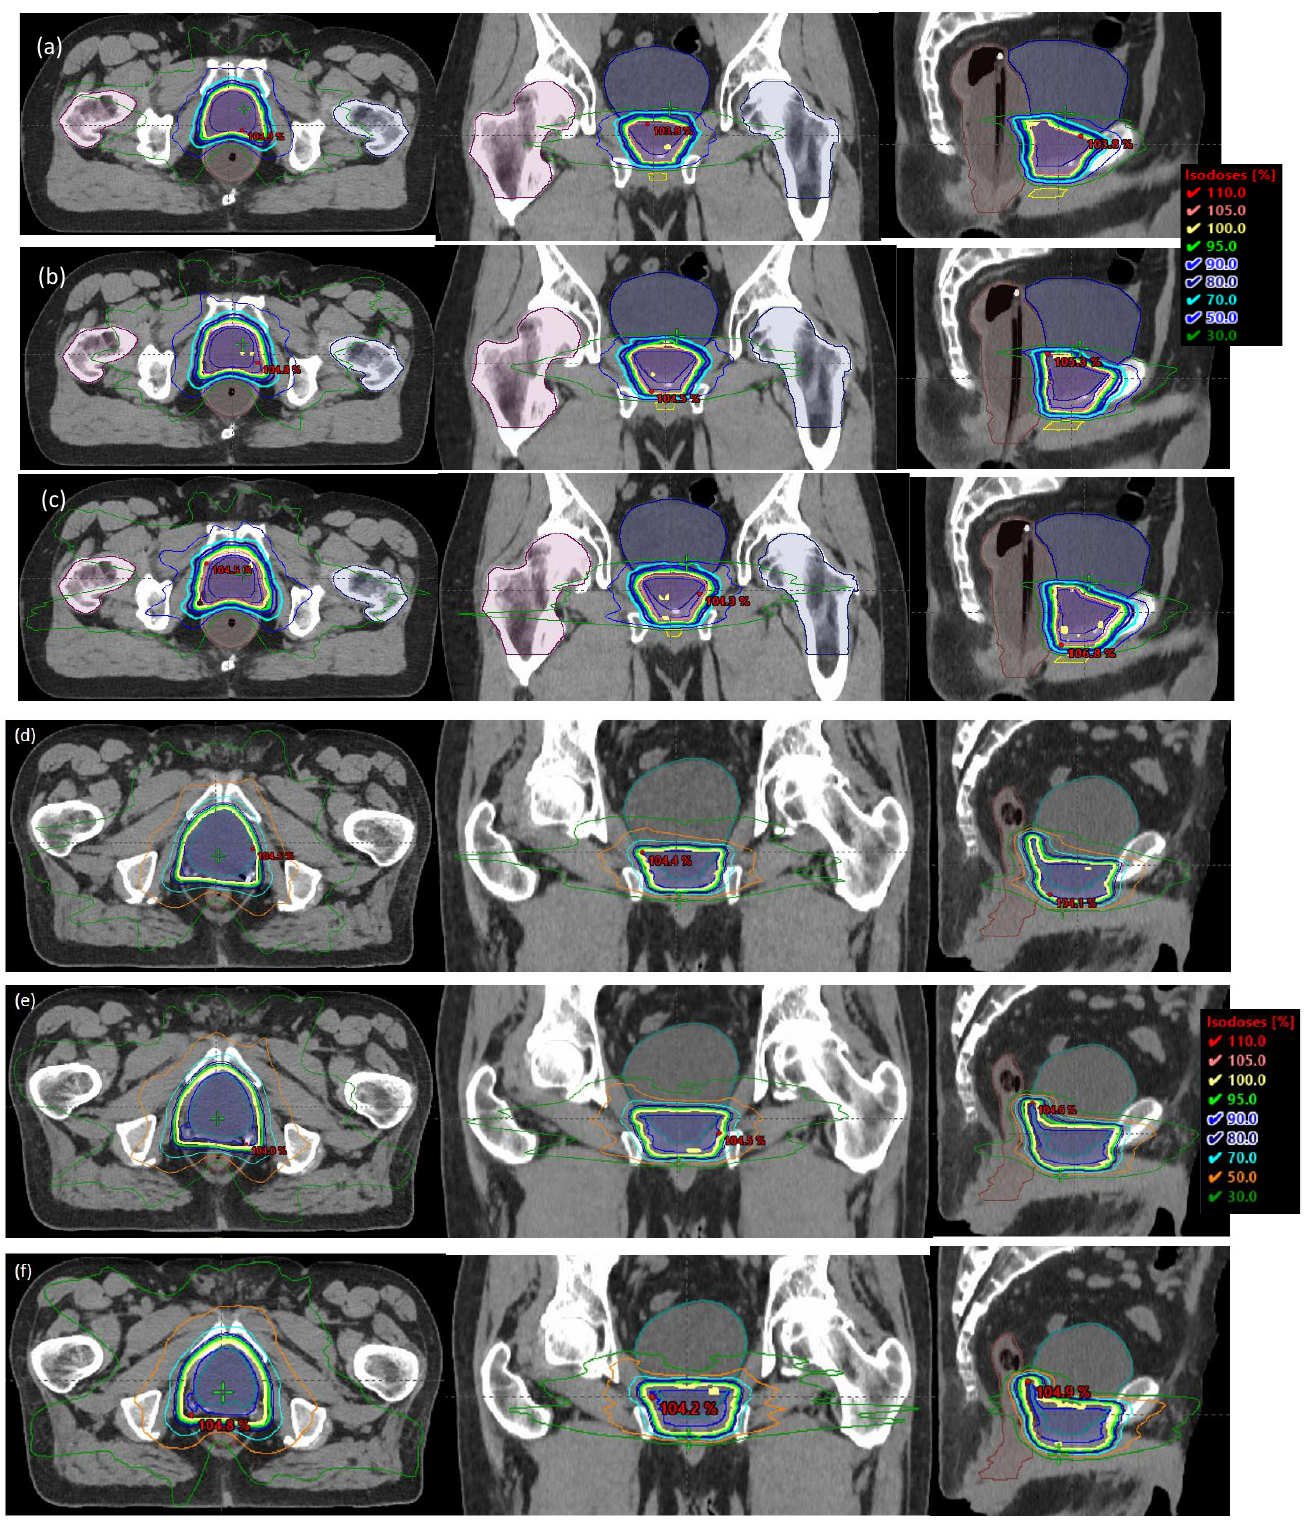
Figure 1. Three plans of 0-, 2-, and 4 mm PTV margins in the axial, coronal, and sagittal views for a patient with ( a – c ) and without ( d – f ) an endorectal balloon.